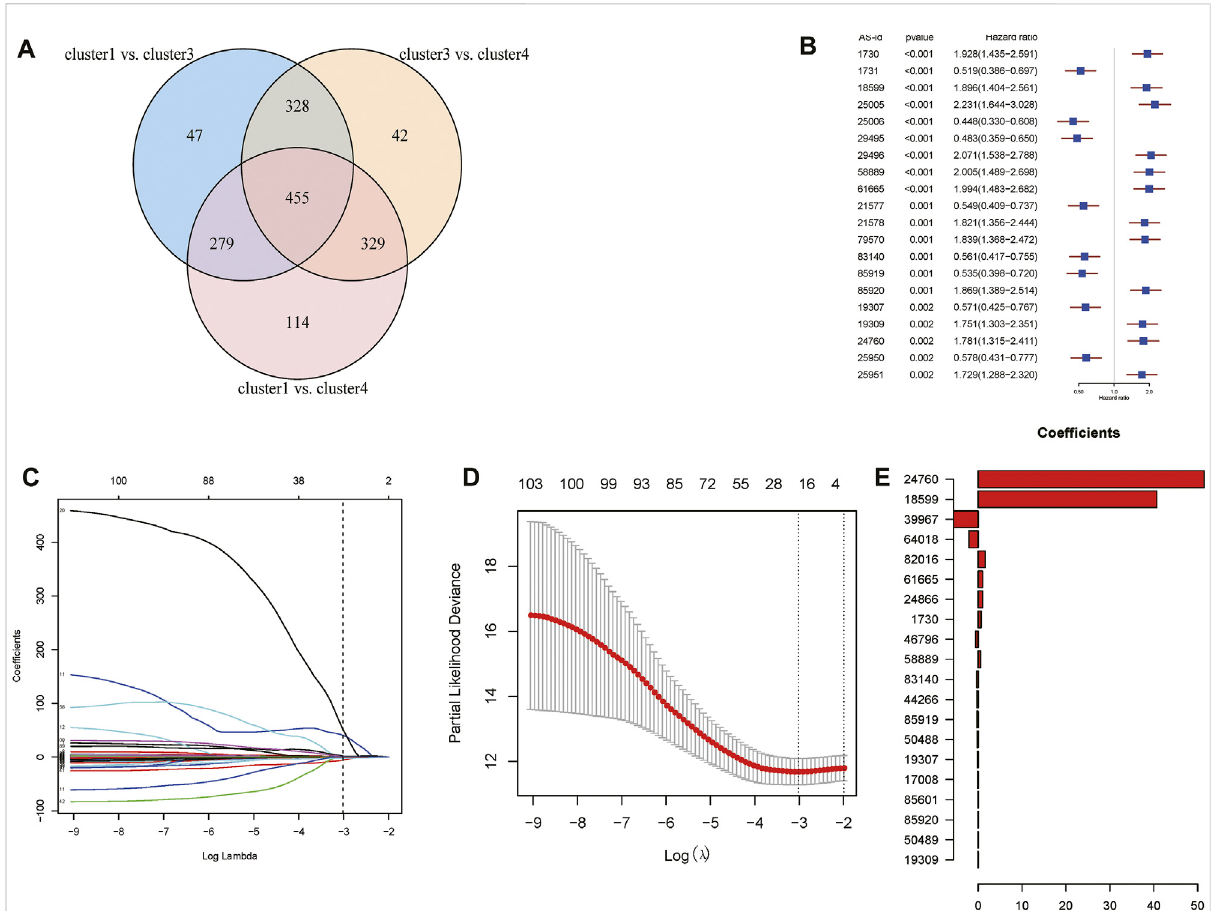
FIGURE 7 Analysis of Differential Alternative Splicing Events between Subtypes. (A) Venn diagram of alternative splicing events for differences between subtypes. (B) Top 20 single factor cox regression results. (C) Display the corresponding changes of lambda and variable coef fi cients. (D) Obtain lambda.min through cross-validation. (E) Display the regression coef fi cients corresponding to the variables after